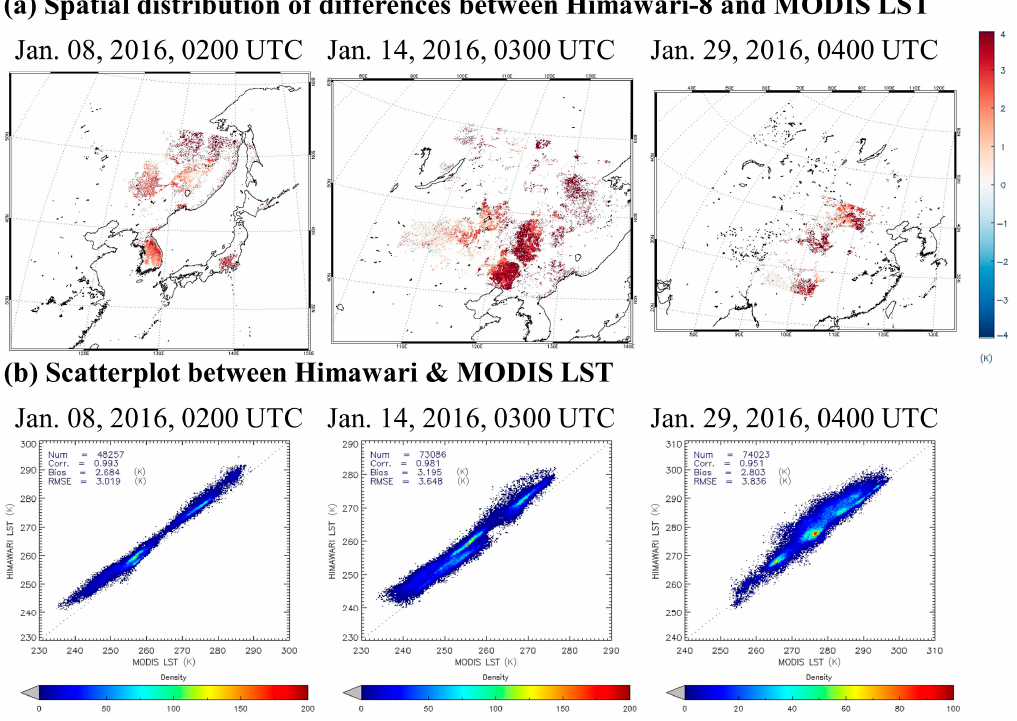
Figure 13. ( a ) Spatial distribution of differences between Himawari ‐ 8 and MODIS LST, and ( b ) scatter plot between Himawari ‐ 8 and MODIS LST in daytime during winter for selected days.